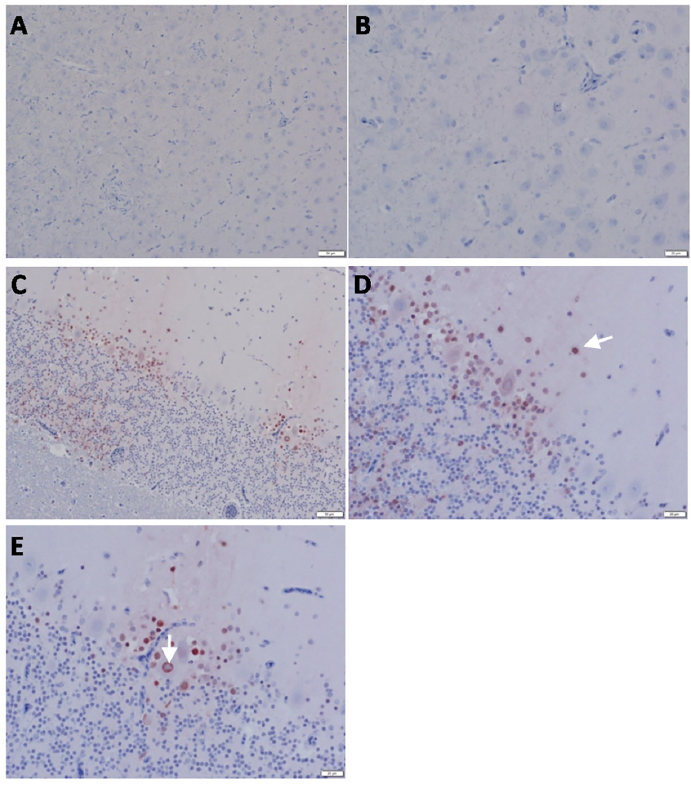
Fig 4. Detection of viral NP antigen in brain by IHC. ( A and B ) Brain of non-infected birds (X = 50 and 20 μ m, respectively). (C ) Perkinji cell layer of cerebellum of infected birds (X = 50 μ m). ( D ) Neurons and glial cells of perkinji cell layer of cerebellum of infected birds (arrow) (X = 20 μ m). ( E ) Endothelial cells of perkinji cell layer of cerebellum of infected birds (arrow) (X = 20 μ